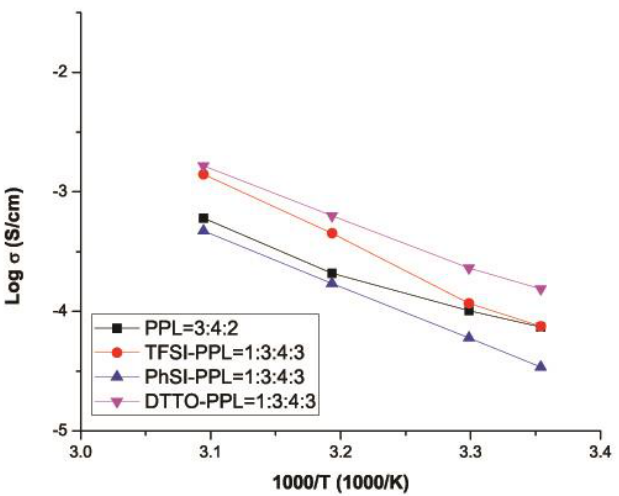
Figure 10. Ionic conductivity versus temperature for the four best performing electrolytes.